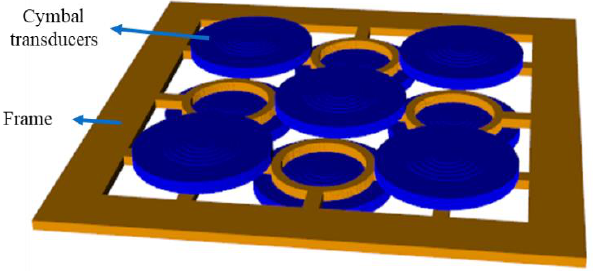
Figure 16. Finite element model of the two-layered 3 3 array with an aluminum frame.